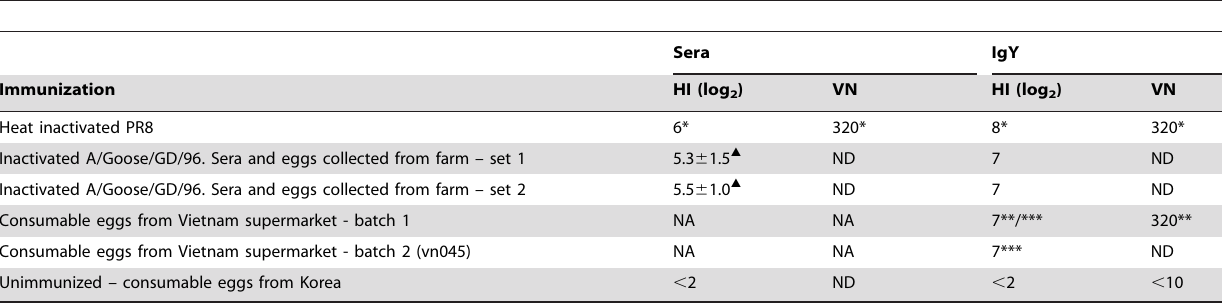
Table 1. Haemagglutination inhibition (HI) and virus neutralization (VN) titers in hen sera and egg